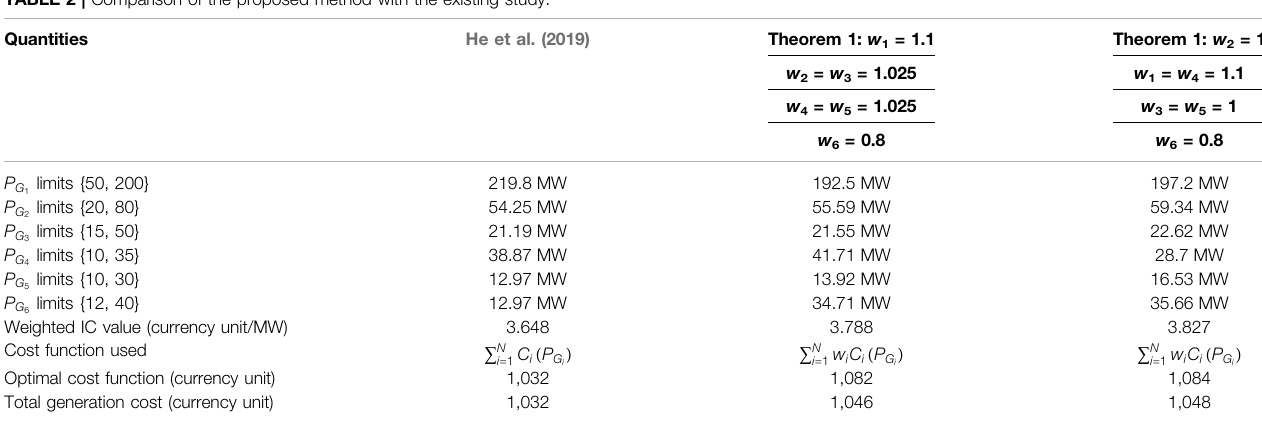
TABLE 2 | Comparison of the proposed method with the existing study. Quantities He et al.